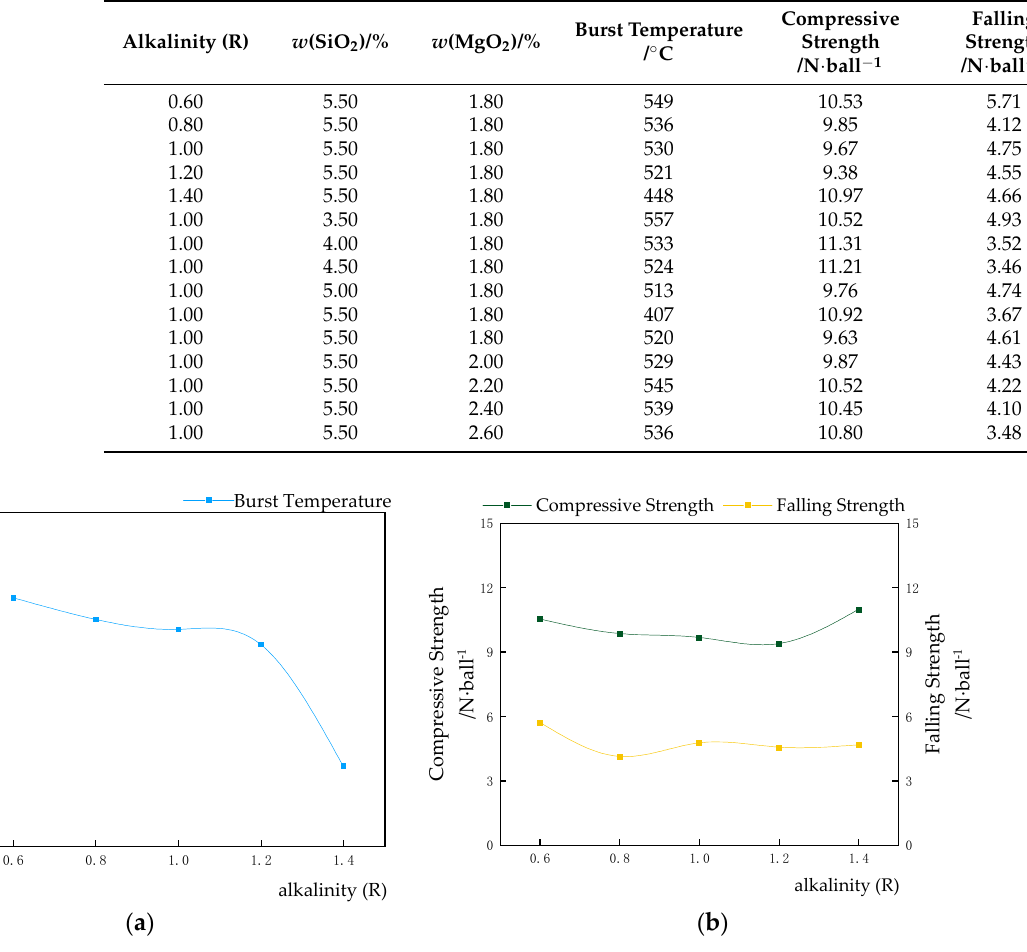
Figure 1. Effect of alkalinity on green pellet performance. ( a ) Burst temperature trend chart, ( b ) Compressive strength and falling strength trend chart.